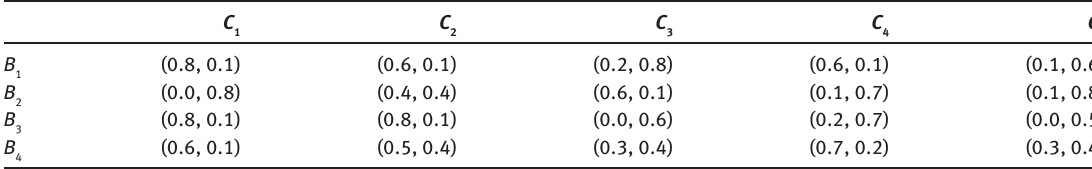
Table 2: Symptoms Characteristic for the Considered Patients.